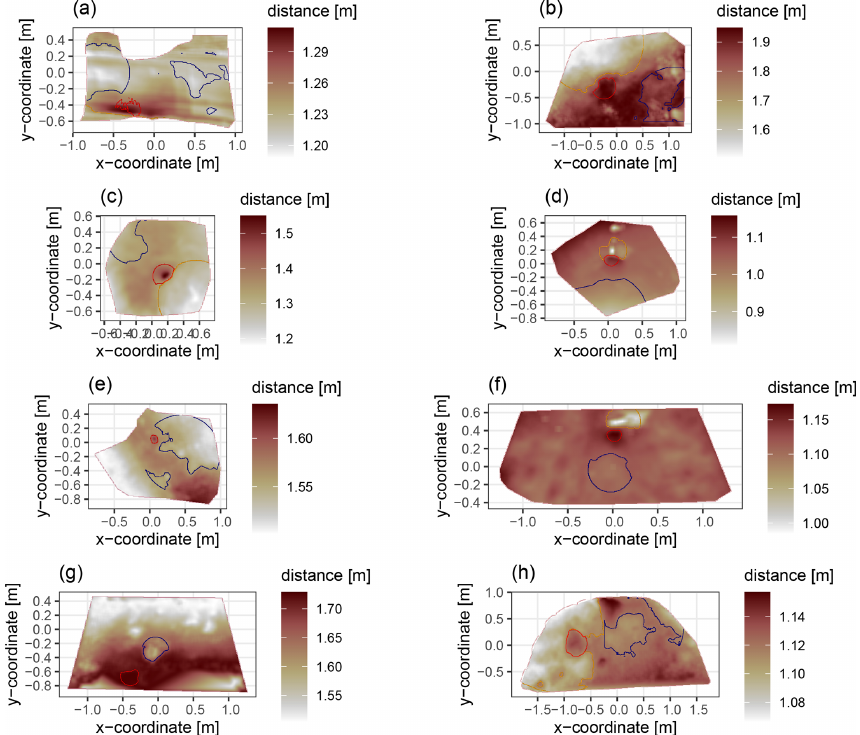
Figure A2. Delineation of the areas. The point of origin of the coordinate system is at the camera nadir. Depth is the distance between the surface and the camera. The red lines show the outline of the burrow entrance. The green lines show the outline of mound. The oranges lines show the outline of burrow roof. The area that is not outlined is burrow-embedded area. The examples shown are as follows: (a) LC-NU,